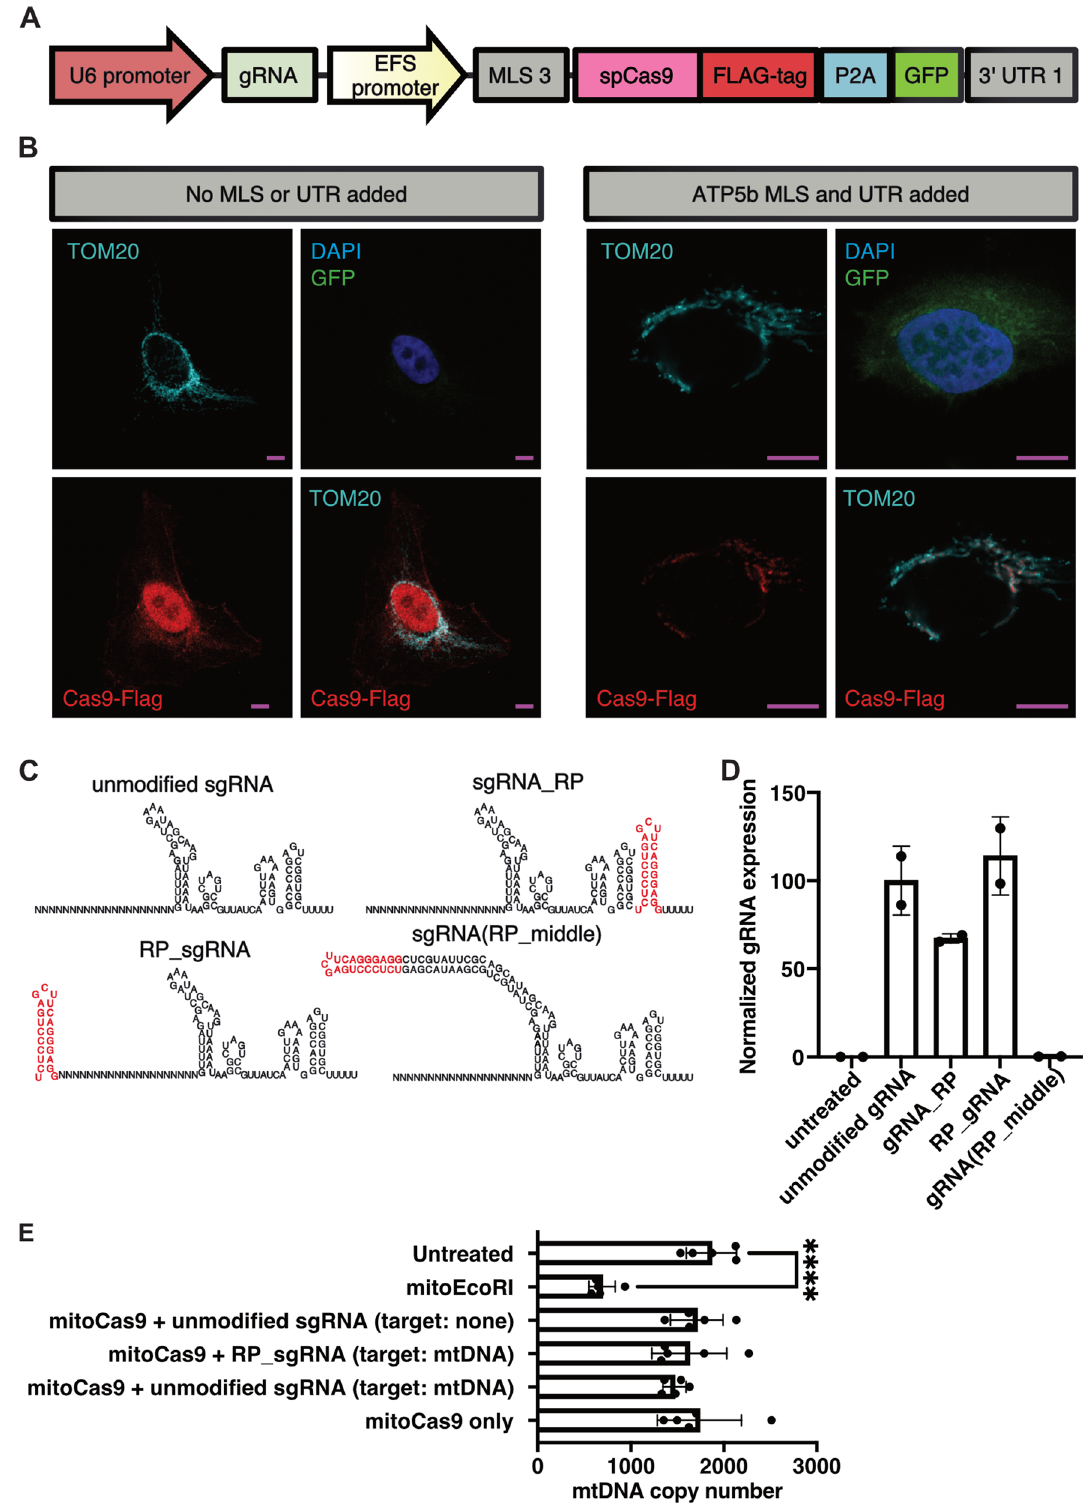
Figure 2. Delivery of spCas9 into mitochondria. ( A ) MLS3 (ATP5b) and UTR1 (ATP5b) were attached to FLAG- tagged spCas9 to facilitate delivery into mitochondria. GFP, separated from spCas9 by a P2A sequence, was included in the construct to enable identification of successfully transfected cells. ( B ) Representative confocal microscopy images of HT1080 cells transfected with spCas9 constructs with or without MLS3 and UTR1 attached. Mitochondria are visualized by TOM20 staining (cyan). Scale bars: 10 μm. ( C ) RP RNA loop sequence (red) was added to different positions of the gRNA to facilitate gRNA delivery to mitochondria. ( D ) Relative expression levels of different sgRNA combinations in HEK 293T cells 2 days post-transfection (n = 2). ( E ) mtDNA copy numbers in HEK293 T cells transfected with different constructs, 2 days post-transfection. Only successfully transfected, GFP + cells were sorted and analyzed with qPCR (n = 5, **** p <